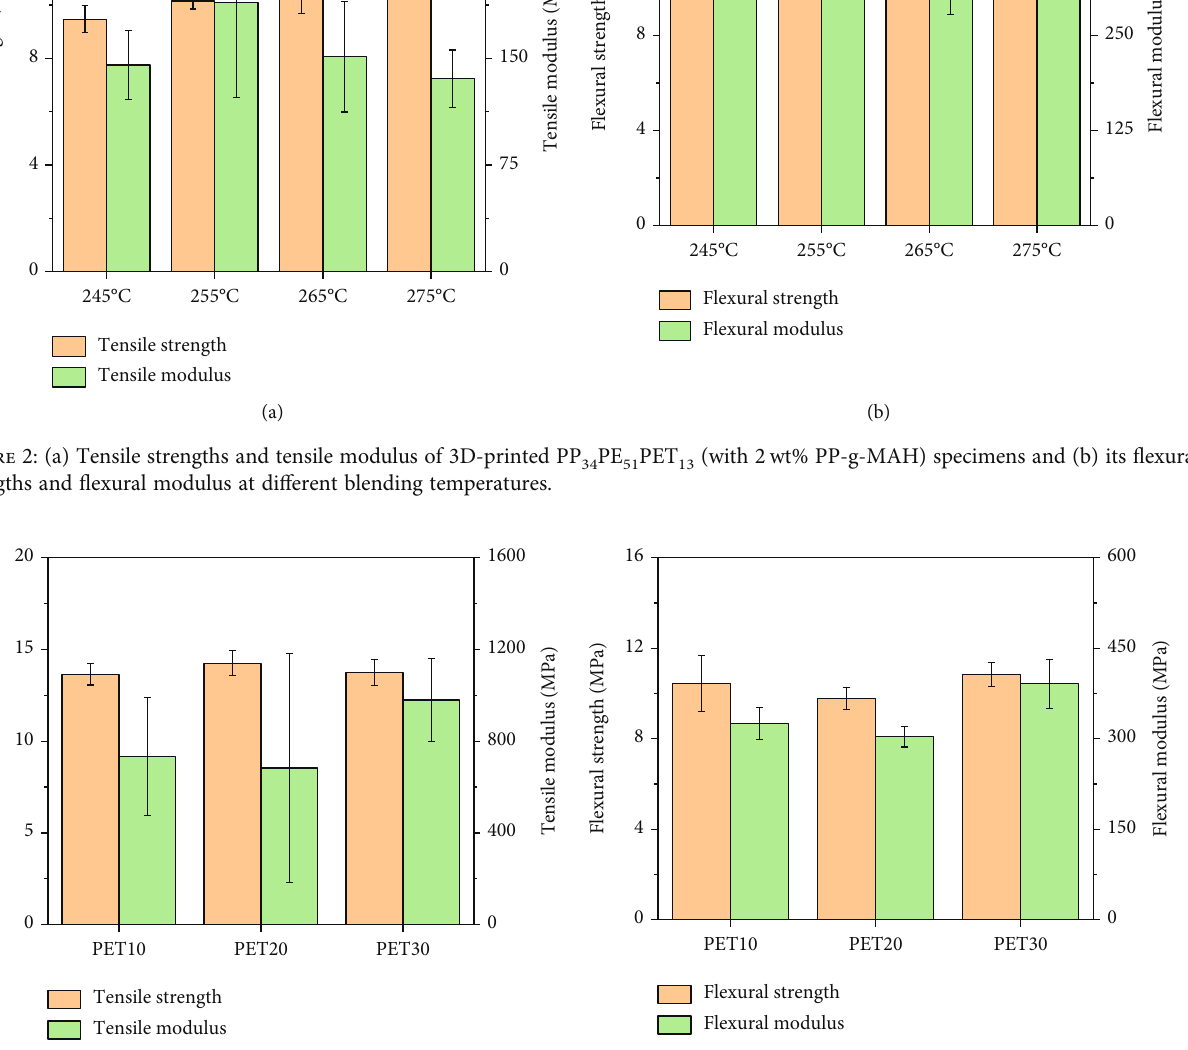
Figure 3: (a) The tensile strength and tensile modulus and (b) the fl exural strength and fl exural modulus of SUPAs with di ff erent PET